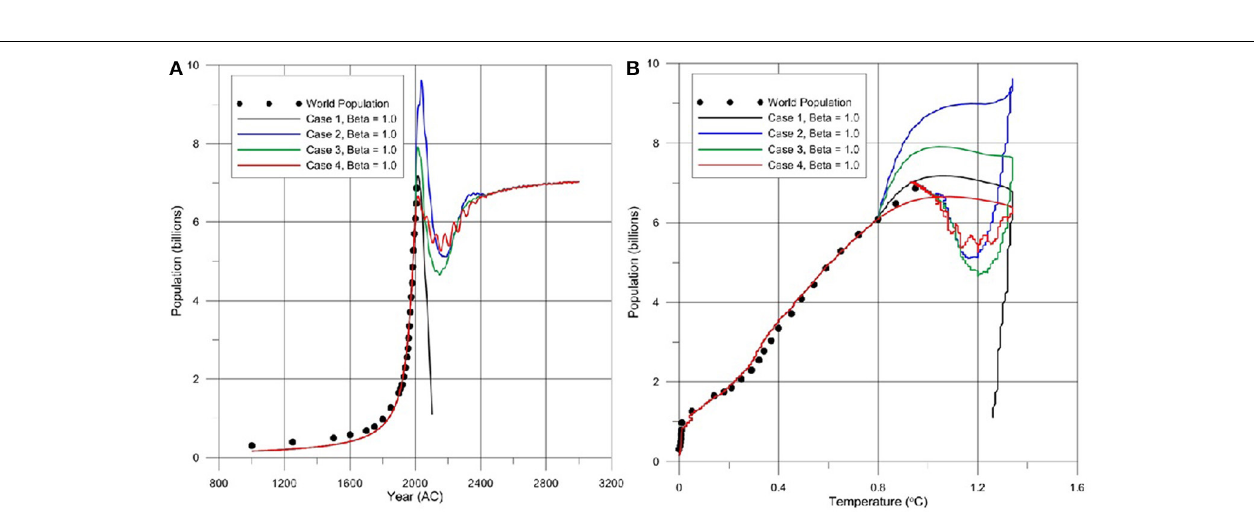
FIGURE 4 | World population stability estimates for 2%/year peak of CO 2 to level of 450ppmv until year 2050 at P c = 8 billion and persistent global temperatures beyond 2050 as predicted in Solomon et al. (2009): (A) Time series plot; and, (B) Stability phase plane